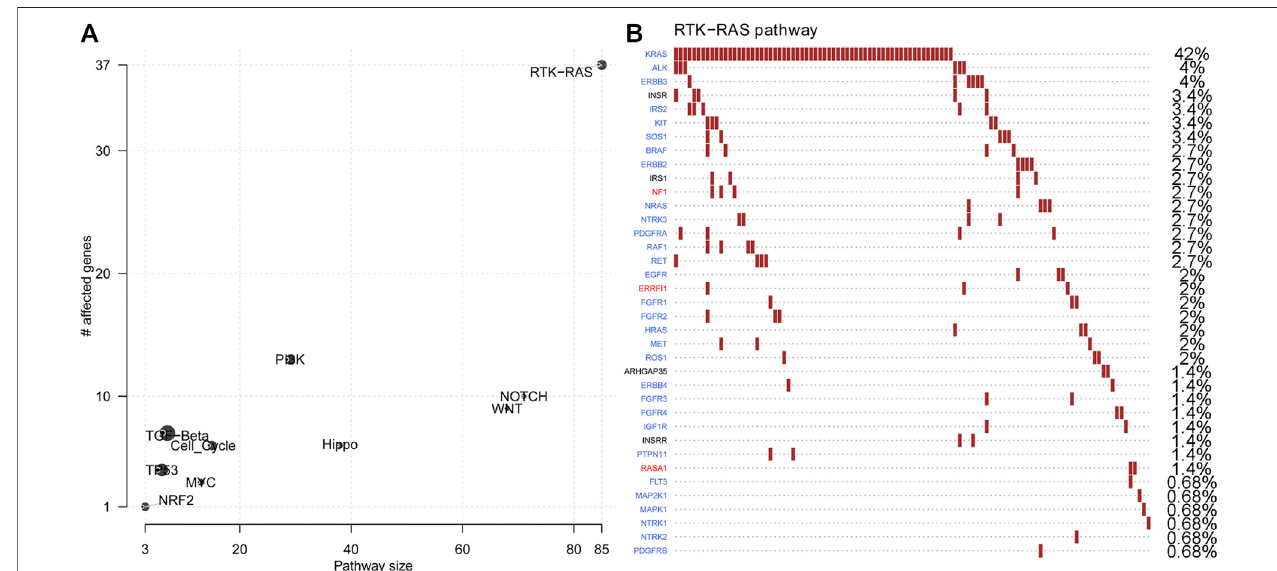
FIGURE 2 | Oncogenic pathway changes and speci fi c gene alterations in the RTK-RAS pathway (A) Oncogenic pathway changes in CRLMs (B) Speci fi c gene alterations in the RTK-RAS pathway in CRLMs. CRLM: Colorectal liver metastases.